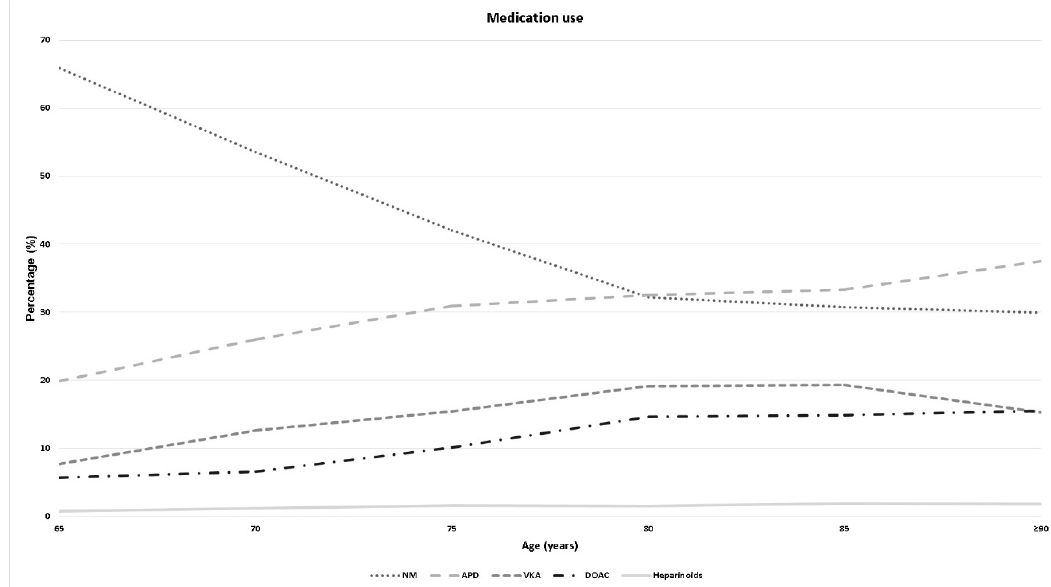
Figure 2. Illustration of medication use throughout different age groups. NM: no anticoagulant medication; APD: antiplatelet drugs; VKA: vitamin K antagonist; DOAC: direct oral anticoagulants.